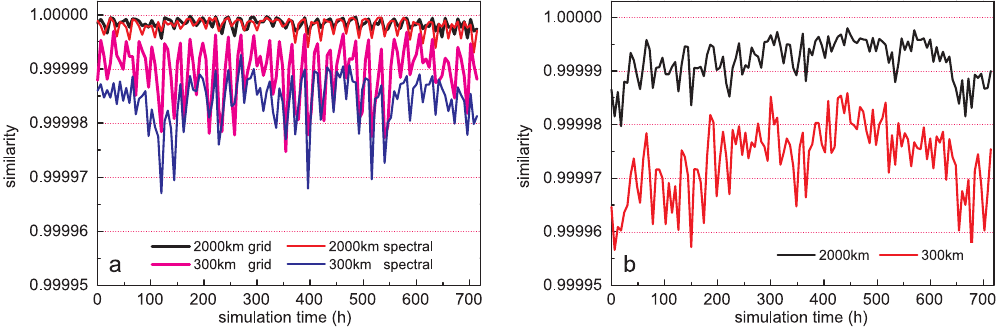
Fig. 1. Time series plots of similarity for temperature at 850hpa, 2000km and 300km scales for July 2009. (a) similarity between NCEP/NCAP and downscaling results by WRF by grid and spectral nudging; (b) similarity between NCEP/NCAR and NARR data.